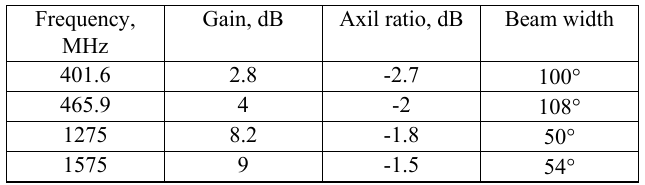
Fig. 4. The axial ratios of the combined antenna at Argos-3 band (a) and GPS L1+L2 band (b). Table 1. Radiation pattern